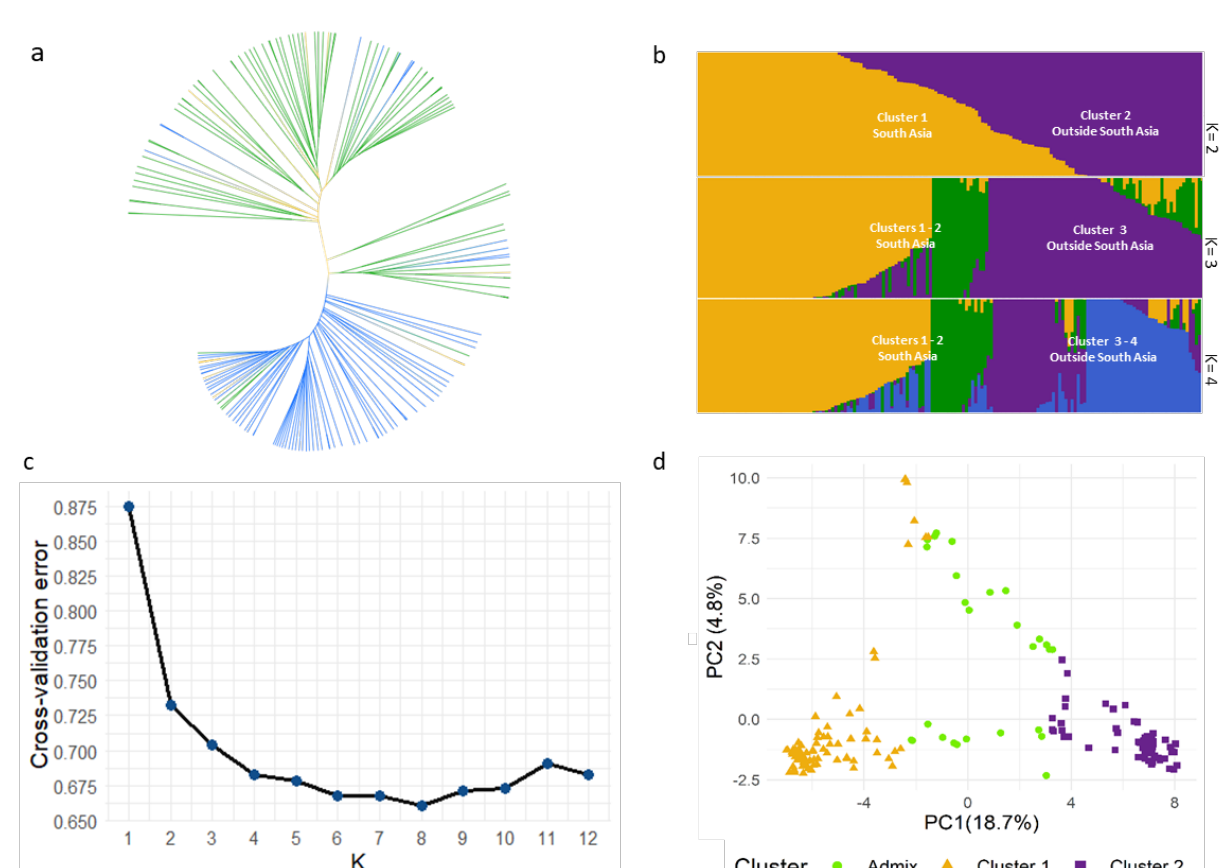
Figure 1. ( a ) Cluster analysis based on genetic distance using an UPGMA tree with branches coloured based on geographical origin: India and Pakistan and rest of South Asia (blue), rest of Asia, Europe, North America, Africa and Australia (green) and unknown origin (yellow). ( b ) Population structure as depicted by a sorted bar plot of ancestry proportions for K = 2 – 4, inferred with ADMIXTURE. ( c ) Ten-fold cross-validation error of ADMIXTURE analyses of K = 1 to 12. ( d ) Principal component analysis (PCA) coloured based on cluster assignment (threshold of 70% membership probability) at K = 2 in ADMIXTURE. Orange triangles used for cluster 1, purple squares for cluster 2 and green dots for admixture cluster.